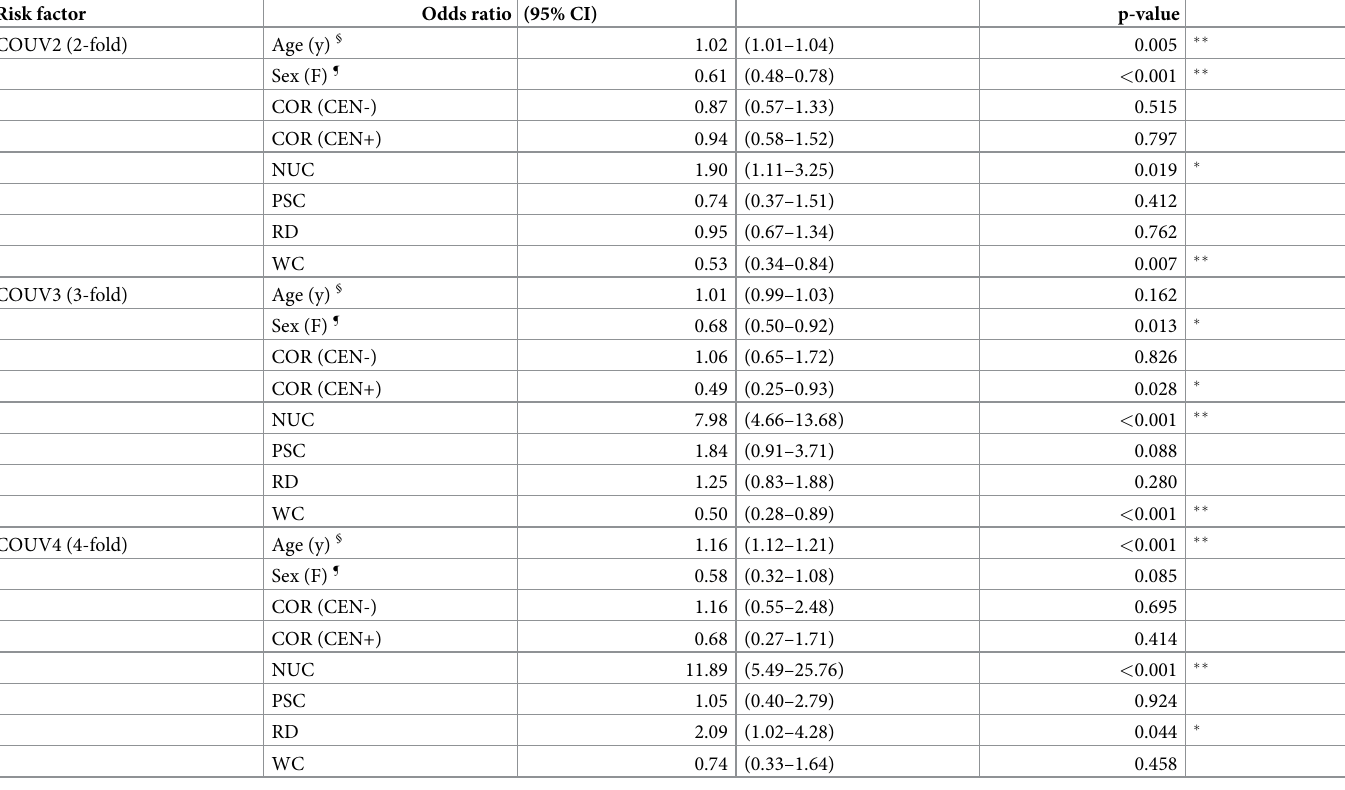
Table 5. Risk of the five types of cataract for two-, three- and four-fold cumulative ocular UV exposure (COUV) based on the mean COUV in Japanese people (all adjusted for age, sex, axial length, and